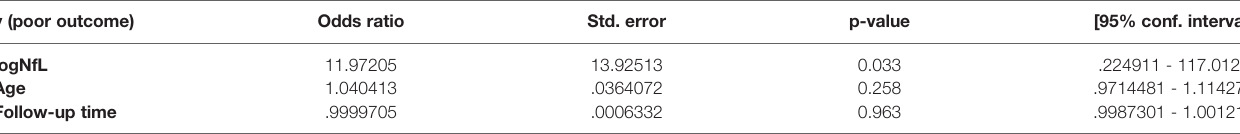
TABLE 2 | Multivariable analysis examining predictors for poor outcome (mRS >2).